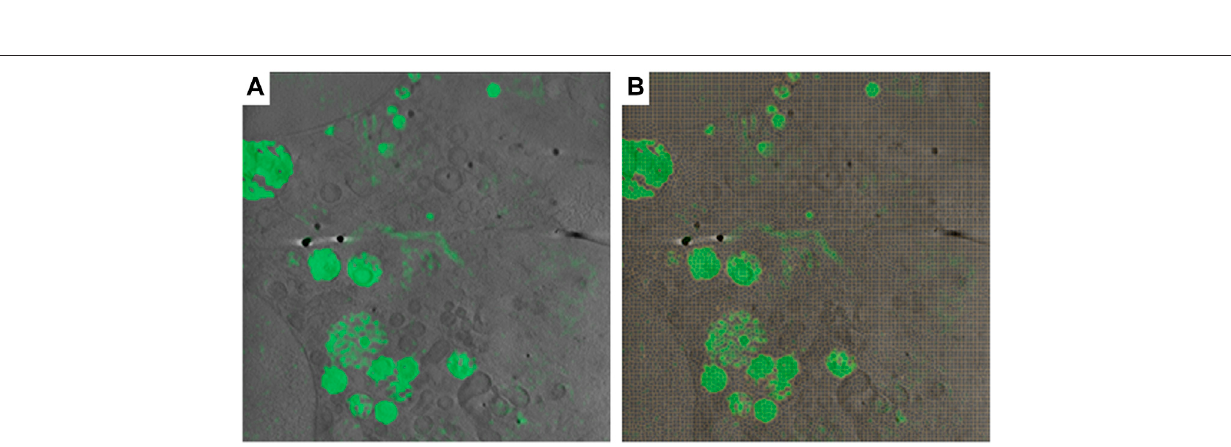
FIGURE 7 | Examples of additional features and use-cases available when using the SuRVoS2 API from within Jupyter notebooks. Example of the SuRVoS2 API being used through a notebook with results which can be visualized using the SuRVoS2 GUI.